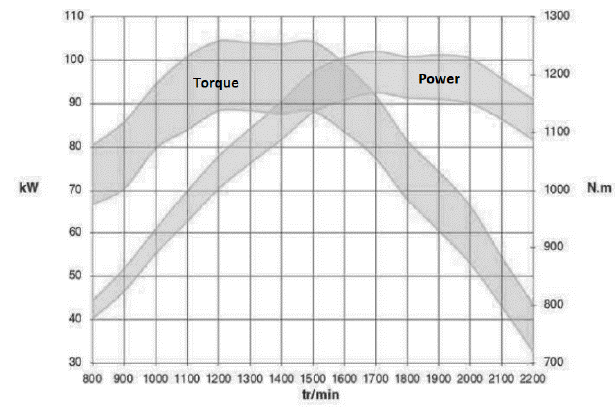
Fig. 3. Characteristics of the combustion engine of the tractor CLAAS Arion 610 [12]